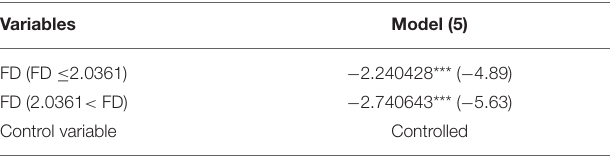
TABLE 9 | Results of the panel threshold effect regression